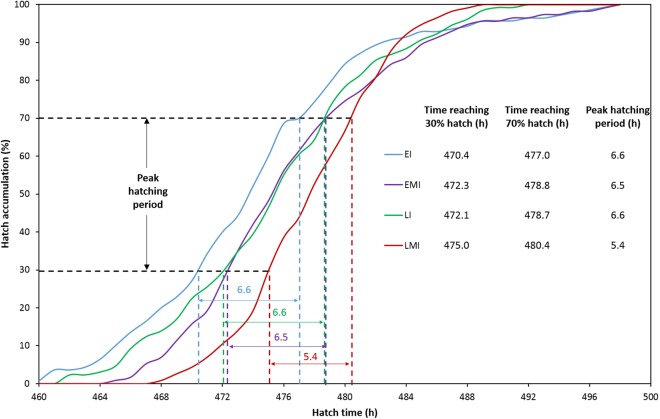
Hatch accumulation of four groups and peak hatching period which defined as 30–70% hatch.The red line (EMI) indicates the latest onset of the hatching process with the shortest peak hatching period.